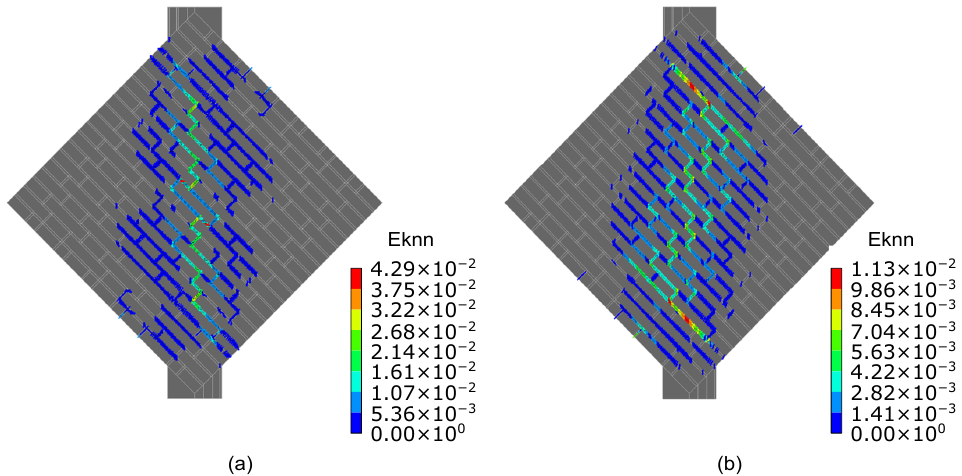
Figure 8. Cracking pattern obtained from the numerical simulations (Eknn denotes the normal crack strain): ( a ) Specimen A with intact mortar layers; ( b ) Specimen B with degraded mortar